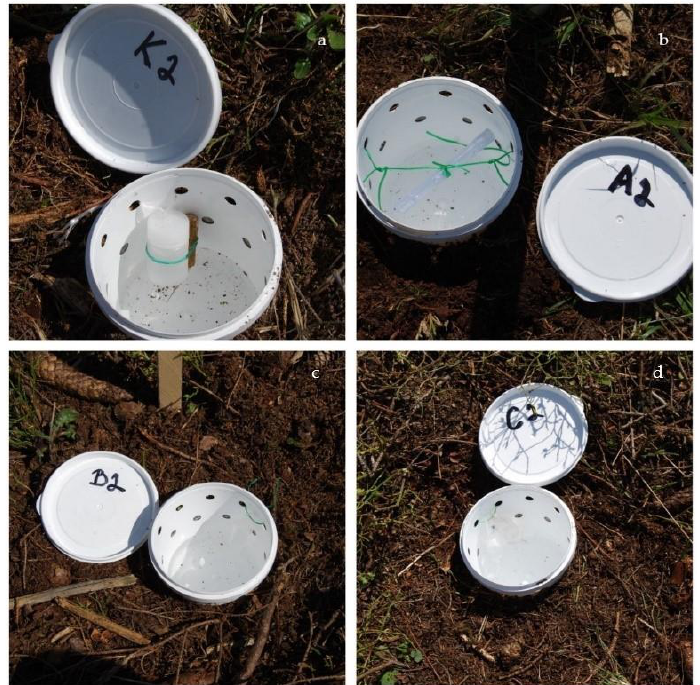
Figure 2. Photographs of representative pitfall traps and different type lure (a-d)